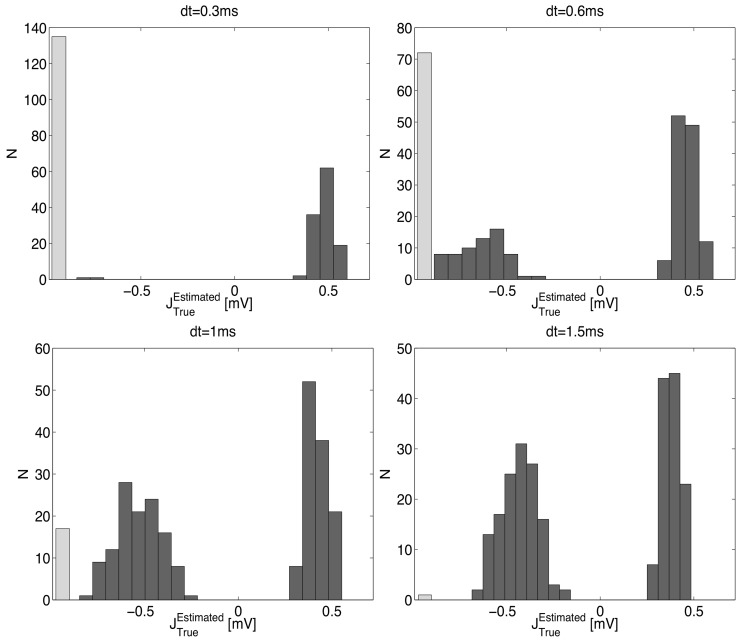
Histograms of JTrueEstimated: theoretical estimates of J
True from the inferred coupling J
Inf for the same network of Fig. 4.The four panels show the histograms of JTrueEstimated (darker bars) for existing synapses only, for different choices of the time-bin dt; for excitatory and inhibitory synapses Eq. (24) and Eq. (26) are applied, respectively. The two peaks already seen in Fig. 4, corresponding to excitatory and inhibitory neurons, are now expected to center around the true values J
True = ±0.54 mV. The light-grey bar in each histogram represents the number of inhibitory synapses for which the found value of J
Inf fell below the lower bound of the physical range, −12<JInf<0, outside of which the relationship in Eq. (26) has no inverse solution; the bar is arbitrarily placed just on the left of the minimum value for JTrueEstimated obtainable by inverting Eq. (26).